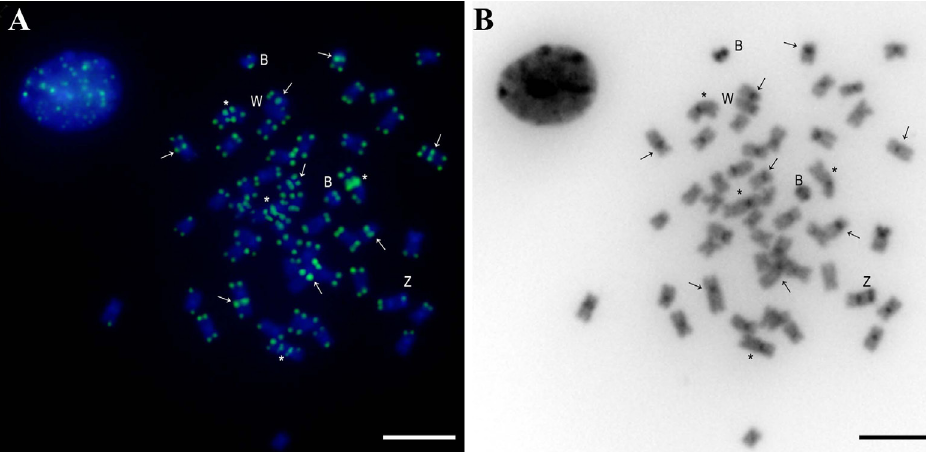
FIGURE 4 | Metaphase of Characidium sp. aff. C. vidali after fluorescent in situ hybridization (FISH); A. With a telomeric probe (TTAGGG) n. B. After sequential C-banding. The arrows indicate Interstitial Telomeric Sites (ITS), and asterisks highlight double-ITS marks; B = B-chromosomes; Z, W = sex chromosomes. Scale bars = 10